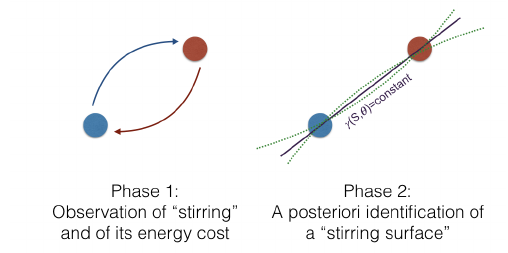
Figure 1. Schematic explanation of how “stirring surfaces” arise and should be constructed in practice. From the observation of an adiabatic and isohaline parcel exchange (left panel), locally-defined stirring surfaces are constructed by empirically “fitting the data” as illustrated in the right panel. The thick black line represents the simplest fit, but alternative fits illustrated by the dotted green lines could also be envisaged if needed. Because the ocean is turbulent, adiabatic and isohaline stirring a priori operates in all possible directions. However, “lateral stirring” only pertains to the “spontaneous” adiabatic and isohaline parcel exchanges having a negative energy cost ∆ E ≤ 0, as explained in